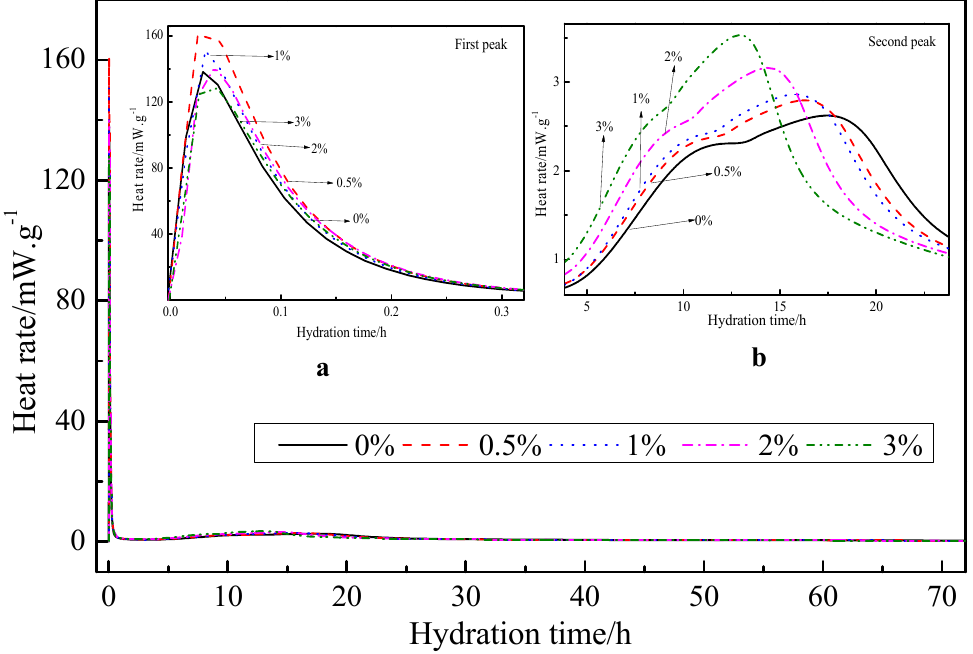
Figure 5. Hydration heat rate of cement paste with di ff erent amounts of nano C-S-H addition.